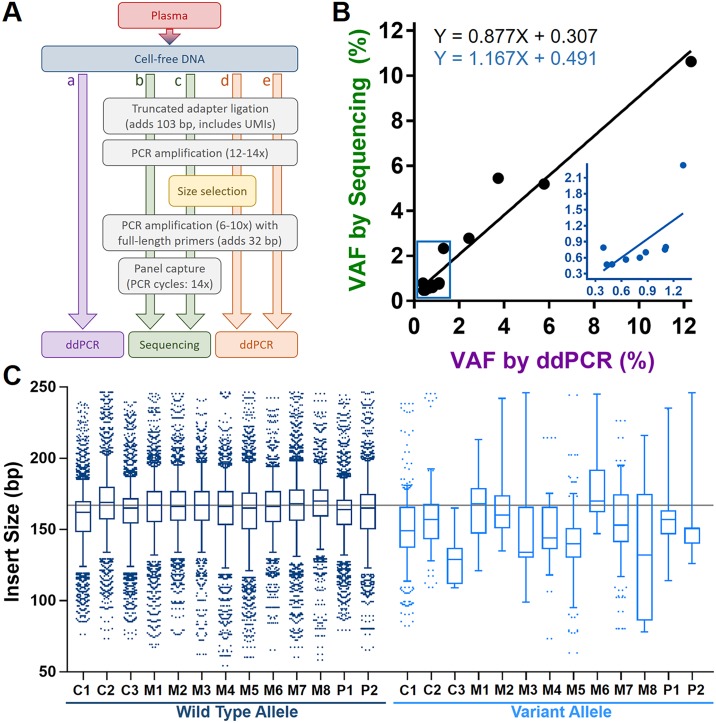
Detection of variant alleles in ccfDNA.Flowchart (A) depicting steps prior to determination of variant allele frequency (VAF). With known variants, VAF can be determined directly from ccfDNA with ddPCR (a), while sequencing requires a multi-step process (b). The addition of truncated adapters followed by extension to full-length in separate steps (b-e) is done to improve resolution during size selection (c, d) of desired subfractions of ccfDNA. There was a strong association (B) between direct measurement of VAF in ccfDNA by ddPCR (A-a) and by the multi-step sequencing process (A-b). This association was present even at VAFs < 1.5% (B-inset). The equations for each colored regression line are shown in a corresponding color. In (C), boxplots of wild type alleles (dark blue) and variant alleles (light blue) by NGS are shown for each cancer patient (C = colorectal adenocarcinoma; M = melanoma; P = pancreatic ductal adenocarcinoma). In (C), data are only shown for insert sizes ≤250 to focus results on the mononucleosome as that length approximates the midpoint between the mononucleosome and dinucleosome lengths associated with ccfDNA. The light gray line identifies the median insert size (167 bp) from all patients. In the majority of patients, the median insert size of the tumor-associated variant allele was shorter than the corresponding wild type allele.